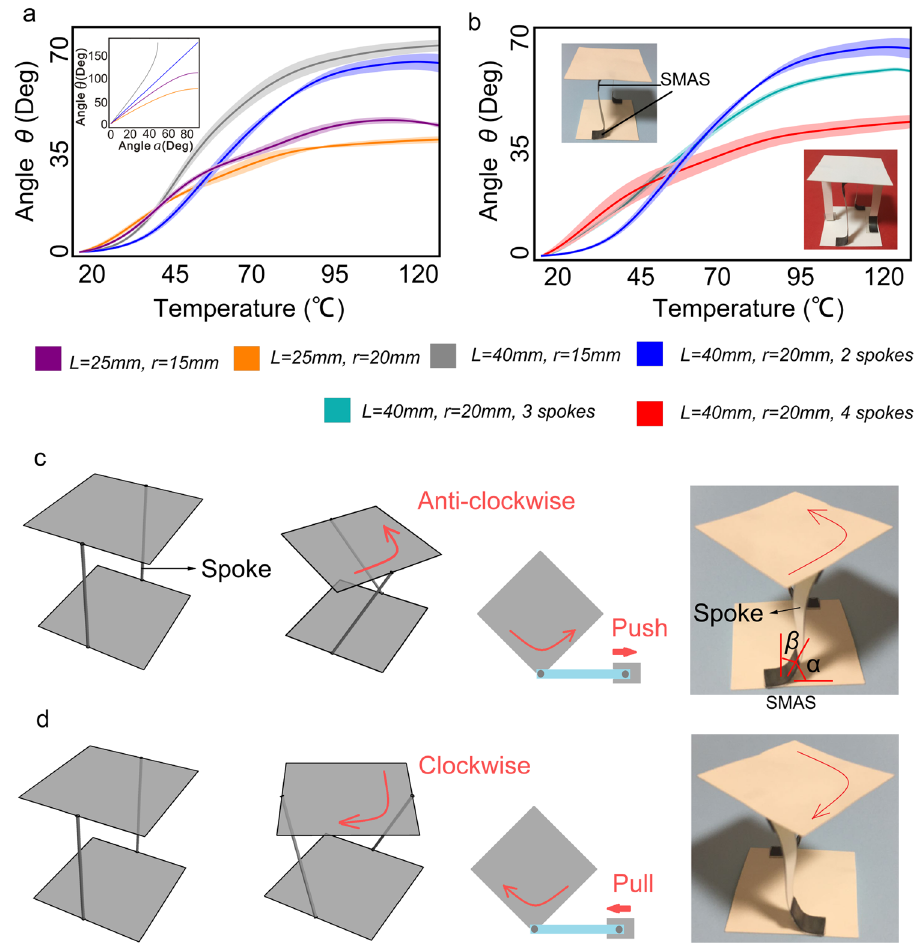
Figure 2: ( a ) θ – temperature relationshipwithdi ff erentgeometricalparametercombinations,inset: θ − α relationshipwithdi ff erentgeometrical parameter combinations. ( b ) θ – temperature relationship with di ff erent number of spokes. The color rule of the curves is shown below the plots (